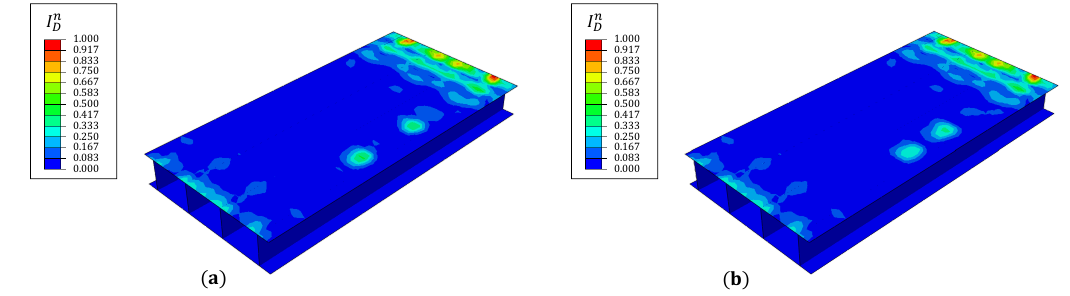
Figure 18. Contour plots of the damage index for damage case ( a ) 2 and ( b )